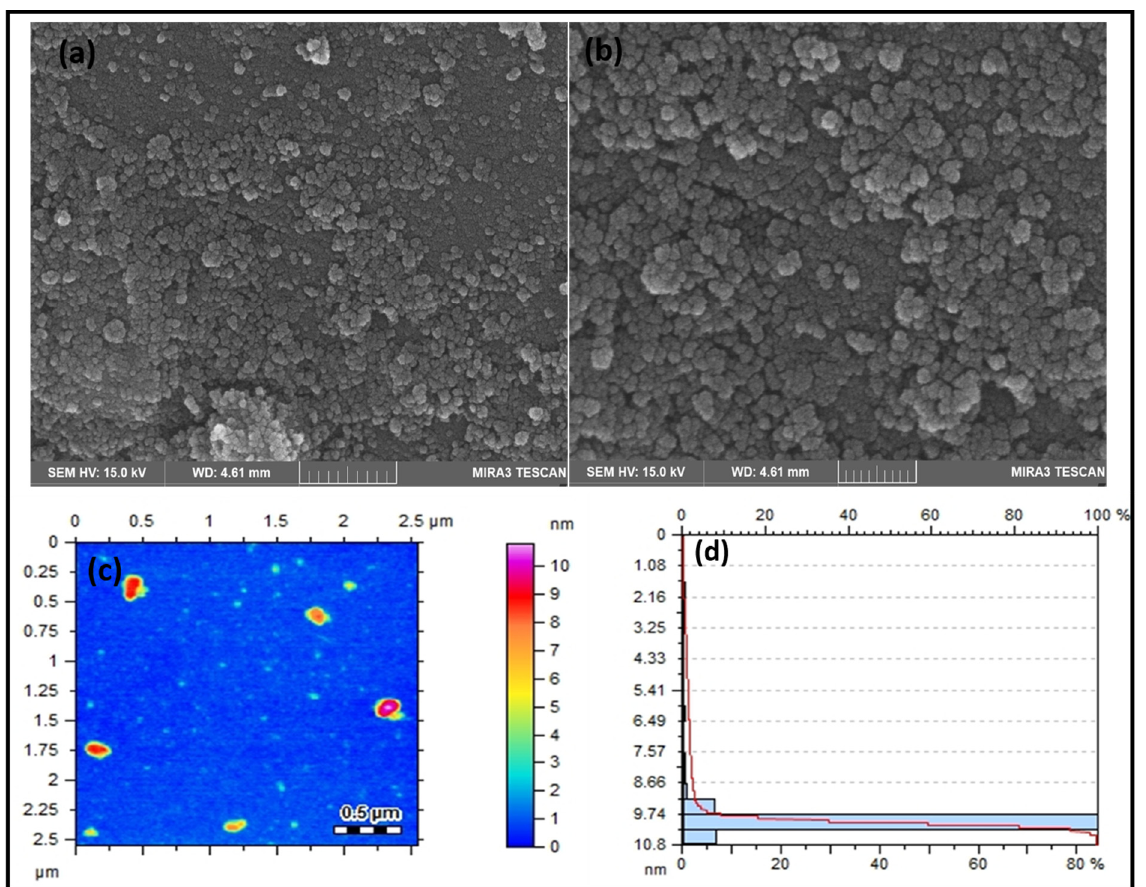
Figure 5. ( a , b ) FESEM images of co-doped titania at different scales; ( c , d ) AFM analysis of co-doped titania showing size (i.e., ≤ 10 nm).